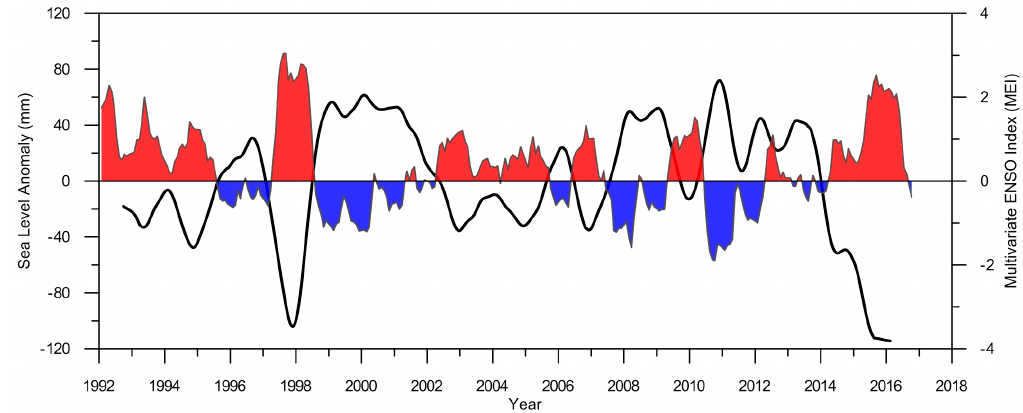
Figure 26. The detrended SLA around the Indonesian Seas (black line) and Multivariate ENSO Index (MEI): El Niño (red) and La Niña (blue).